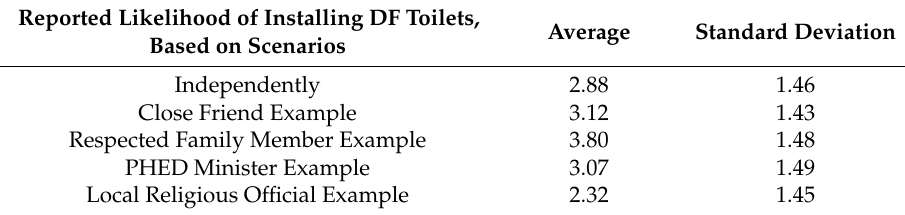
Table 3. Survey responses on reported likelihood of installing DF toilets in various scenarios, on a Likert scale (1 = “Very Unlikely”, 3 = “Neither Likely nor Unlikely”, 5 = “Very Likely”). Reported Likelihood of Installing DF Toilets, Average Standard Deviation Based on Scenarios Independently